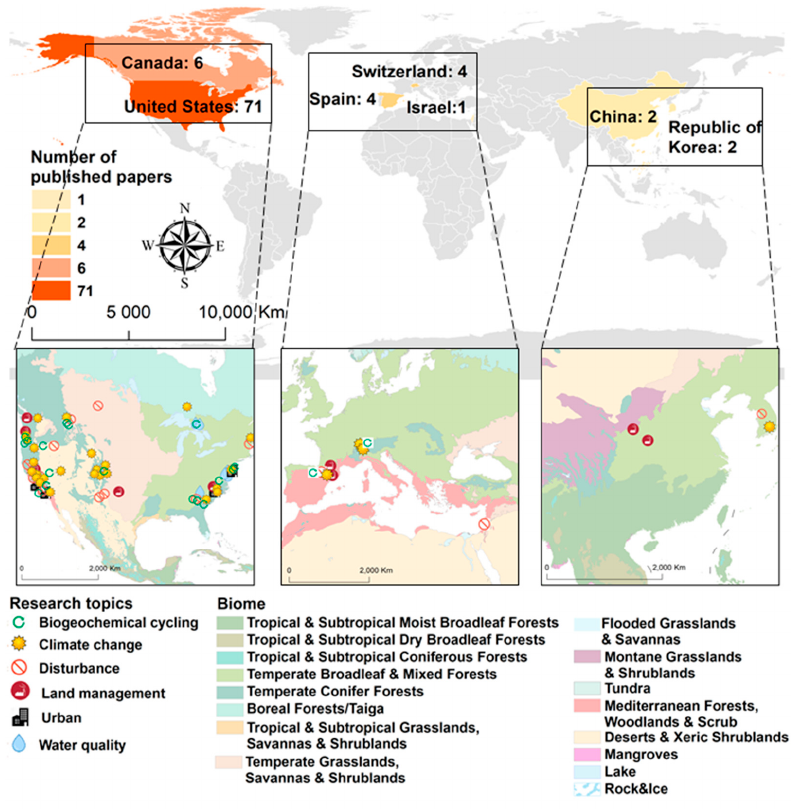
Figure 6. The number of published RHESSys-related papers in different countries and the distribution of the research area in global biomes.